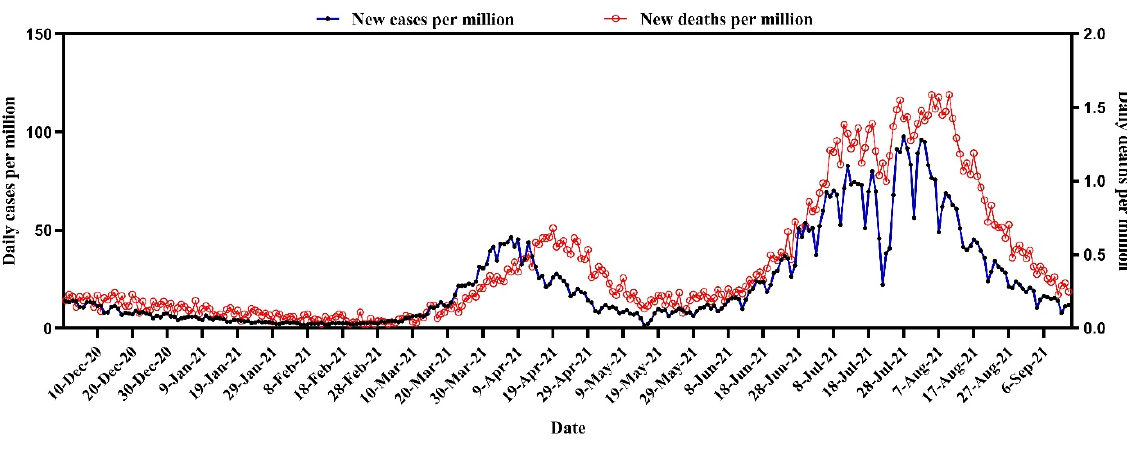
Figure 1. Temporal trend of COVID-19 cases and deaths in Bangladesh (per million).